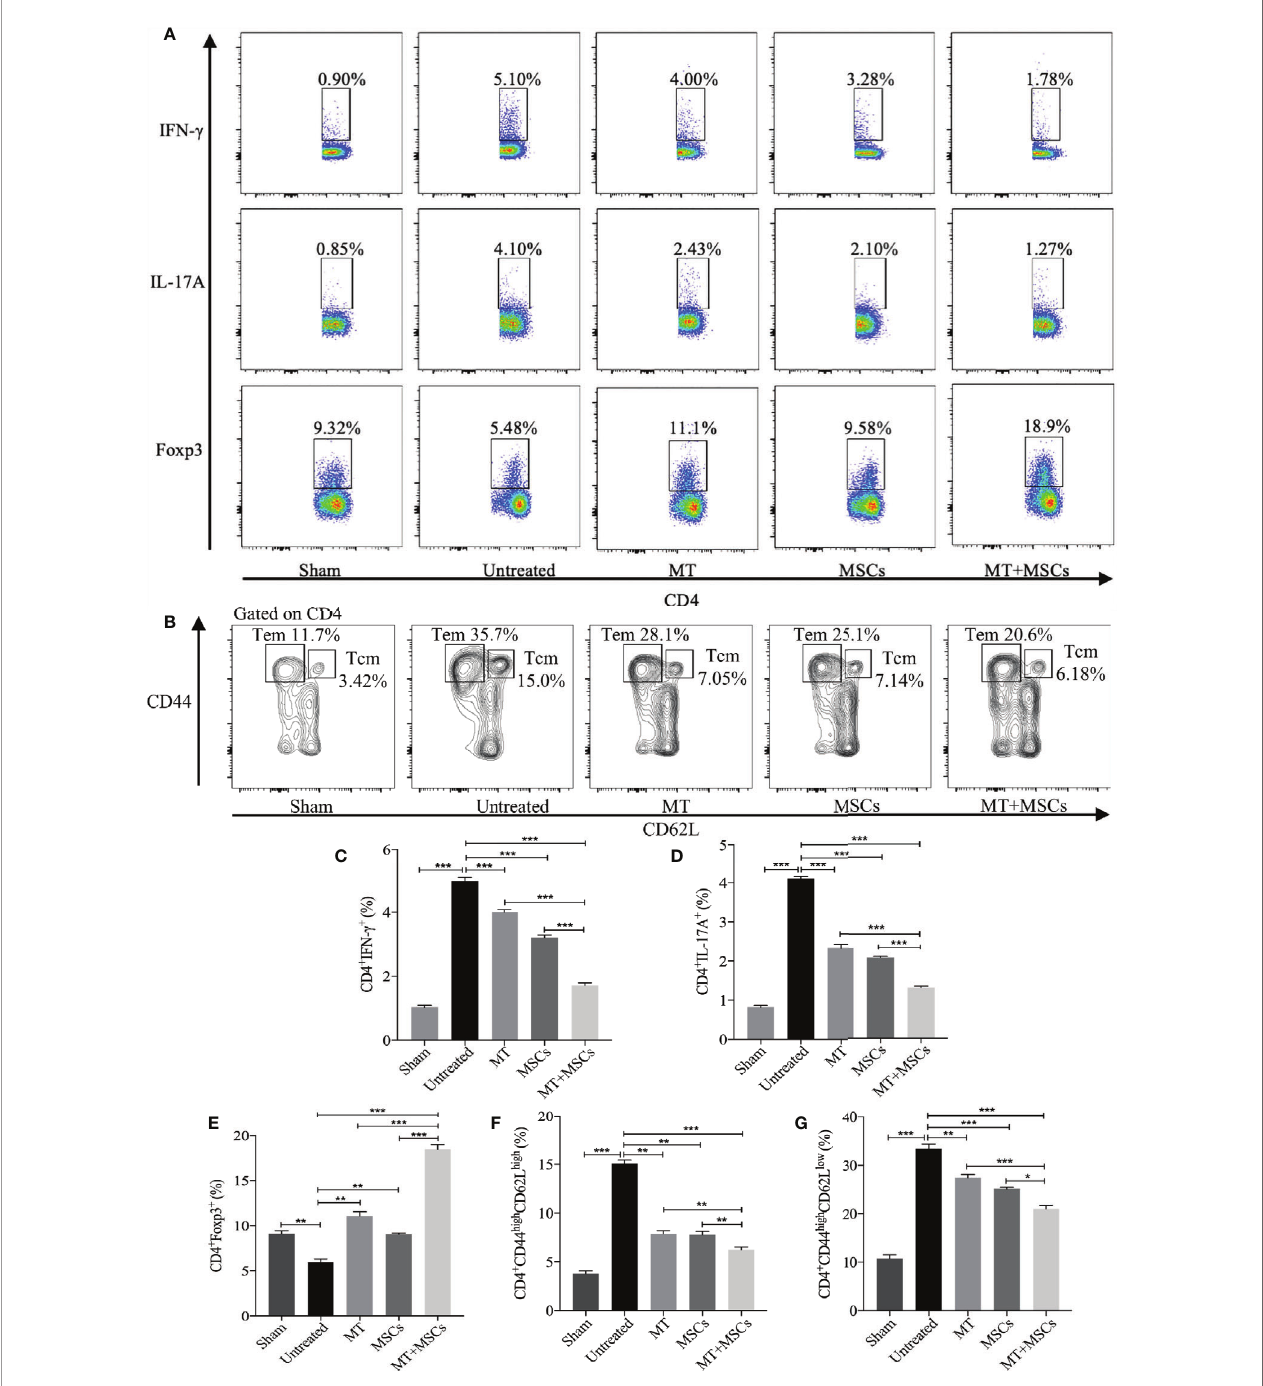
FIGURE 6 | MT either alone or combined with MSCs reduces splenic Th1, Th17, CD4 + Tcm, and CD4 + Tem, but enhances Treg population in the aorta transplant recipients. Splenocytes are collected from the B6 recipient mice of each group at postoperative day 40. (A) The pseudocolor of Th1 (CD4 + IFN- g + ) cells, Th17 (CD4 + IL-17A + ) cells, and CD4 + Foxp3 + Tregs in vivo ; (B) The contour plot of Tem (CD4 + CD44 high CD62L low ) and Tcm (CD4 + CD44 high CD62L high ) in vivo ; (C) The percentage of Th1 cells; (D) The percentage of Th17 cells; (E) The percentage of Tregs; (F) The percentage of Tcm in vivo ; (G) The percentage of Tem in vivo . Statistical analysis is performed by one-way analysis of variance (ANOVA), n = 10 per group, * p <.05, ** p <.01, and *** p <.001. Bar graphs represent mean ± SEM. MT, melatonin; MSCs, mesenchymal stromal cells. The experiments were independently repeated three